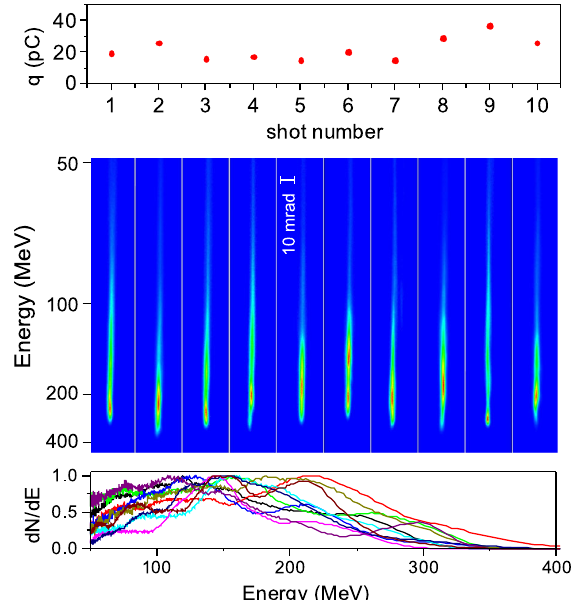
FIG. 5. LANEX images of spatially dispersed beams and spectral lineouts (bottom panel) for ten consecutive shots taken at n e ¼ 1 : 1 (cid:2) 10 19 cm (cid:3) 3 and P ¼ 41 TW . The color scale is normalized for each shot. The top panel shows the integrated charge accounting for background noise on the detector.